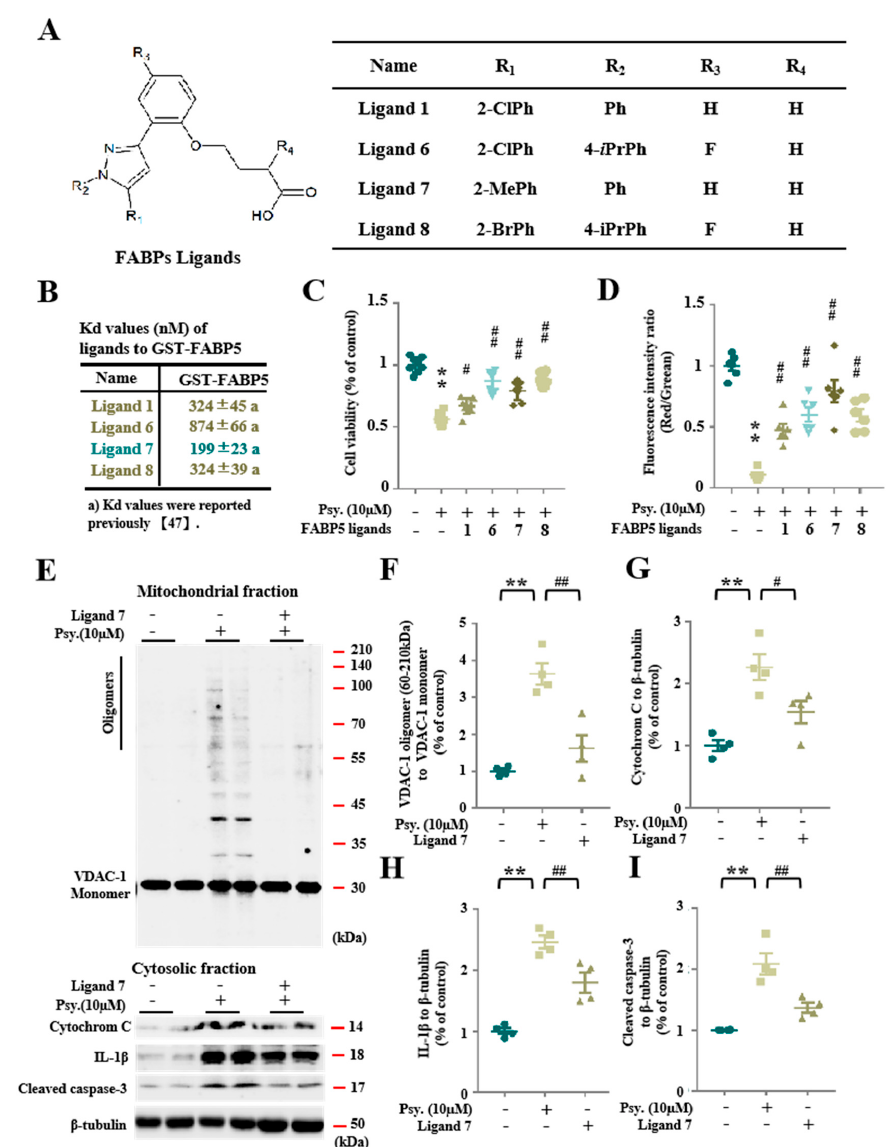
Figure 5. Pharmacological inhibition of FABP5 attenuates psychosine toxicity towards mitochondria. ( A ) Structures of FABP ligands. ( B ) Kd values (nM) of ligands to GST-FABP5, Kd values were reported previously [28]. ( C ) Cell viability analysis of KG-1C, based on the CCK assay. KG-1C cells were treated with psychosine (10 µ M) or FABP ligands. Treatment with FABP ligands rescued cell viability, especially in ligand 6- and ligand 8-treated cells ( n = 8). ( D ) Analysis of mitochondrial membrane potential by JC-1 assay. KG-1C cells were treated with psychosine (10 µ M) or FABPs ligands (1 µ M). Treatment with FABPs ligands recovered the mitochondrial membrane potential in treated cells, especially in ligand 7-treated cells ( n = 6). ( E ) Western blot analysis of VDAC-1 oligomers in mitochondrial fraction (top), and cytochrome C, IL-1 β and cleaved caspase-3 in cytosolic fraction (bottom). ( F – I ) Quantification of ( E ), showing decreased VDAC-1 oligomer levels in the mitochondrial fraction in ligand 7 (1 µ M)-treated cells compared to psychosine-treated cells ( n = 4), and decreased levels of cytochrome C, IL-1 β and cleaved caspase-3 in cytosolic fraction in ligand 7 (1 µ M)-treated cells compared to psychosine-treated cells ( n = 4). The data are shown as mean ± standard error of the mean and were obtained using a one-way analysis of variance. ** p < 0.01; # p < 0.05 and ## p < 0.01. Cont., control; Psy.,